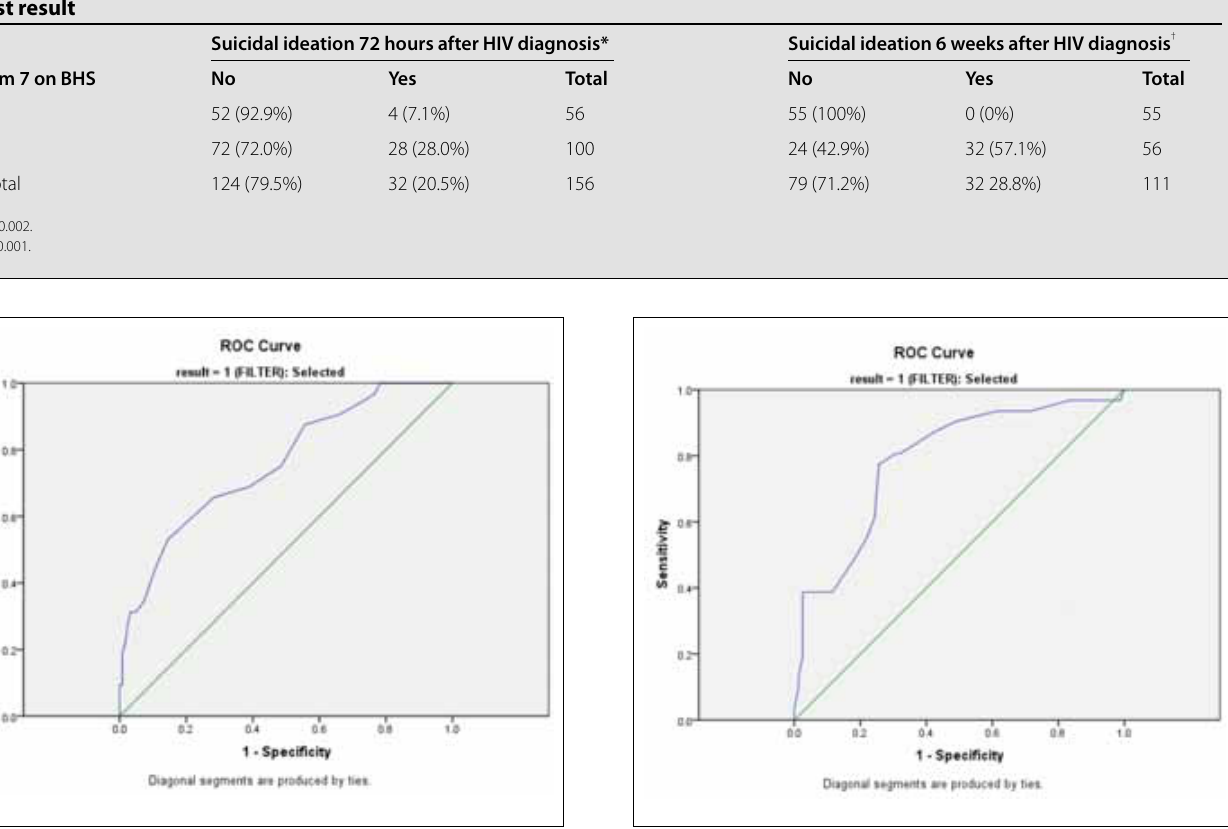
Fig 2. ROC curve of BDI scores v. suicidal ideation (BHS scores) in HIV-positive patients 6 weeks after HIV diagnosis.